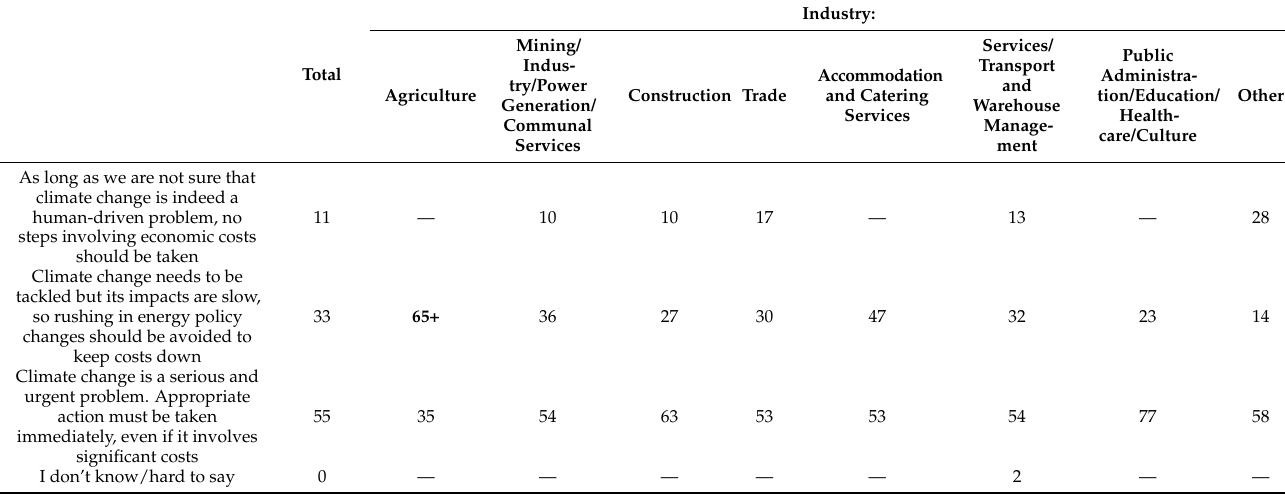
Table 5. What should individual countries do about climate change? (in percentage